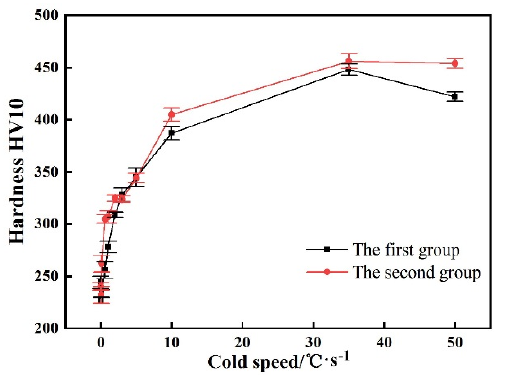
Figure 12. Hardness of the rolled and quenched specimens at different cooling rates.